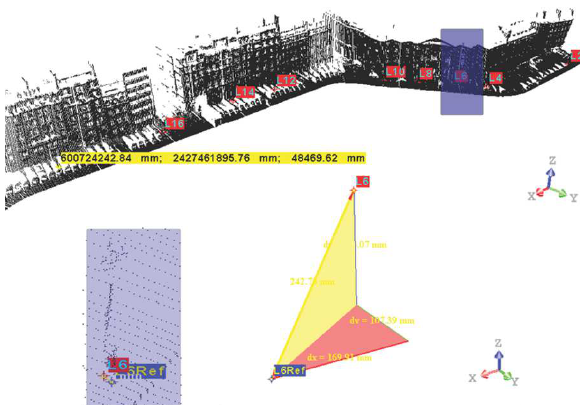
Fig. 6. Road section in 5th district of Paris. Interactive extraction of “lamppost” in Lara3D point clouds. Lamppost can in the reference point selection.